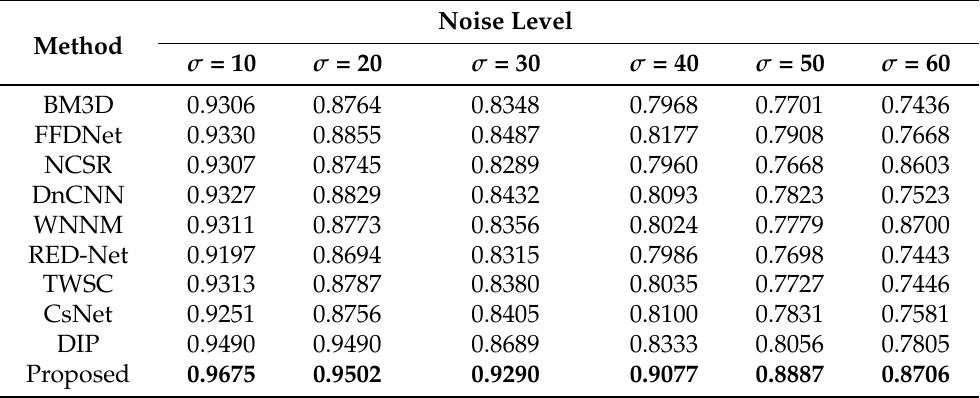
Table 7. Average SSIM results of different methods on 10 commonly used images with various noise levels.